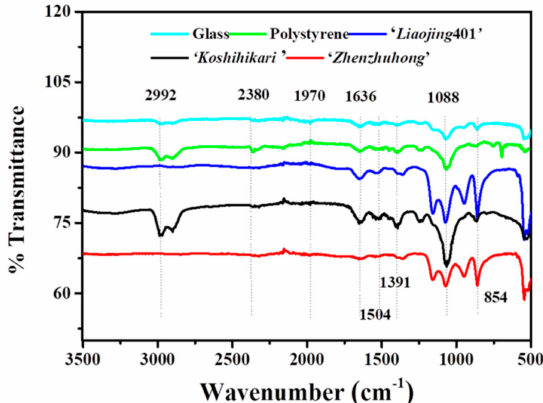
Figure 5. FTIR characterization of the biofilm extracellular matrix on glass, ‘ Liaojing 401’, ‘ Koshihikari ’, ‘ Zhenzhuhong ’ and polystyrene.